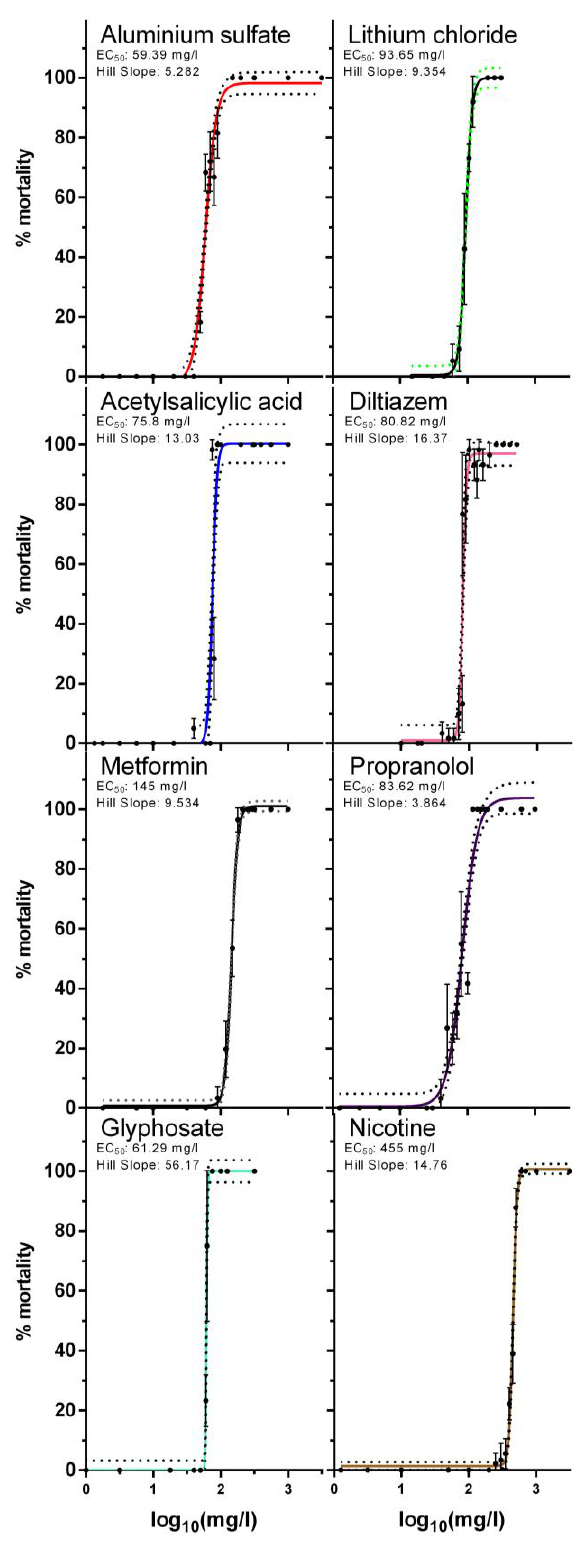
Figure 2. Acute toxicity curves for individual chemicals in this study. Data represent average ± standard deviation (N = 4 replicates).